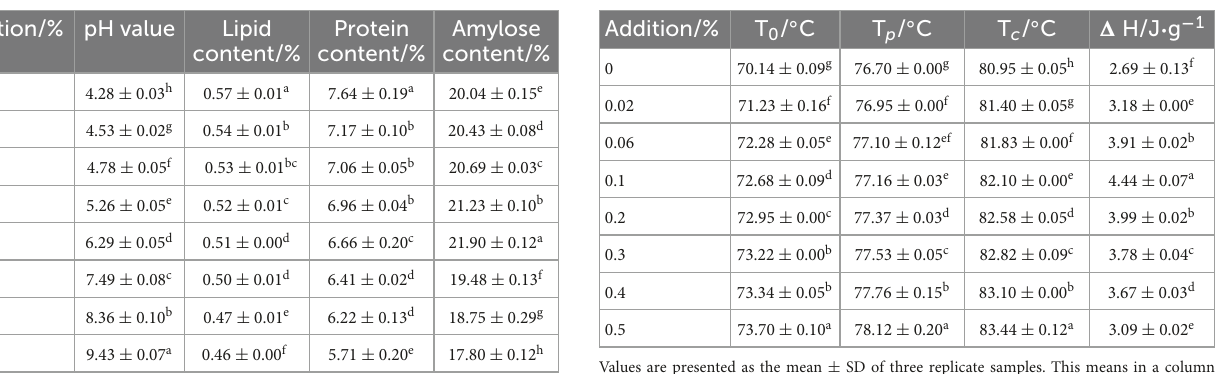
TABLE 4 Effect of sodium bicarbonate on the thermal properties of rice flour.